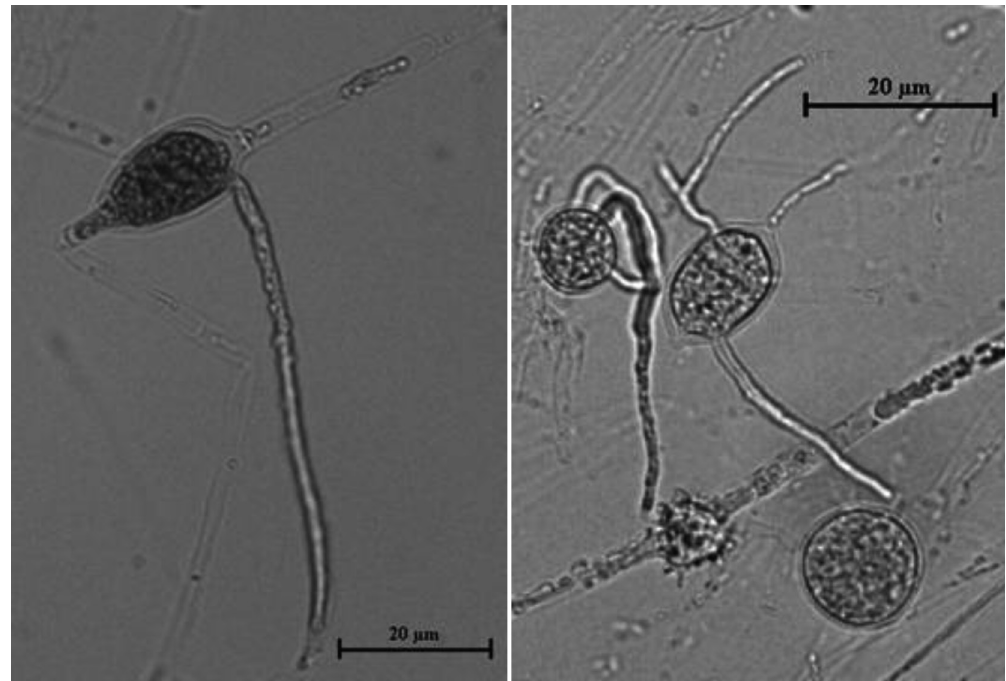
Figure 1. Germinating hyphal bodies of Pythium spiculum . a) intercalary ovoid hyphal body with a long germ tube, b) cylindrical and subspherical hyphal bodies with more than one germ tube, one of them